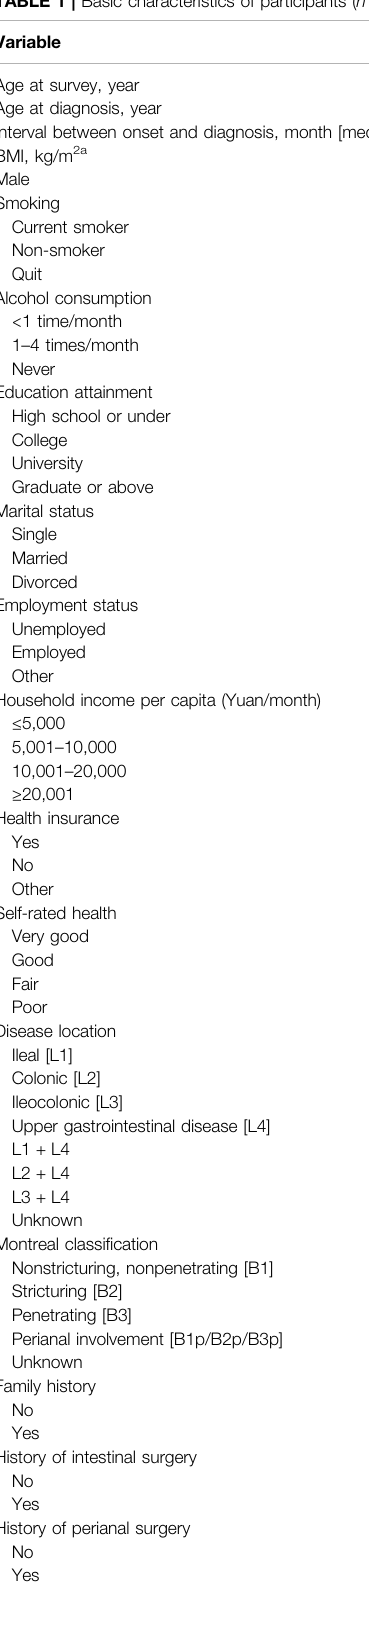
TABLE 1 | Basic characteristics of participants ( n (cid:1)